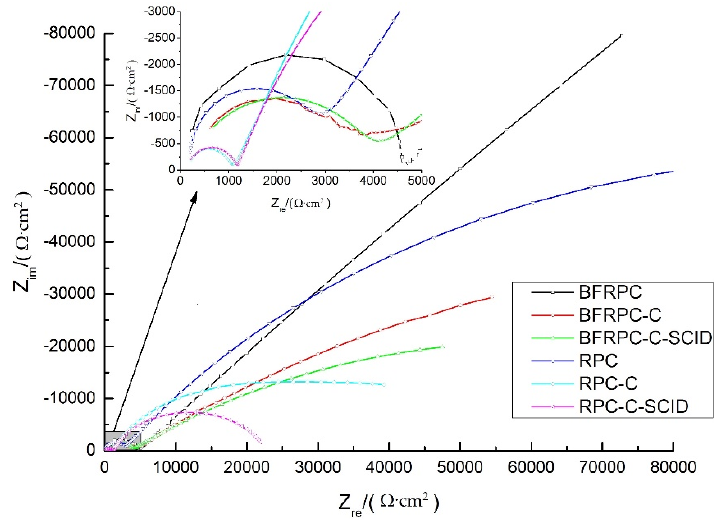
Figure 10. Nyquist curves of steel bars embedded in the specimens (chloride ion penetration time: 28d).